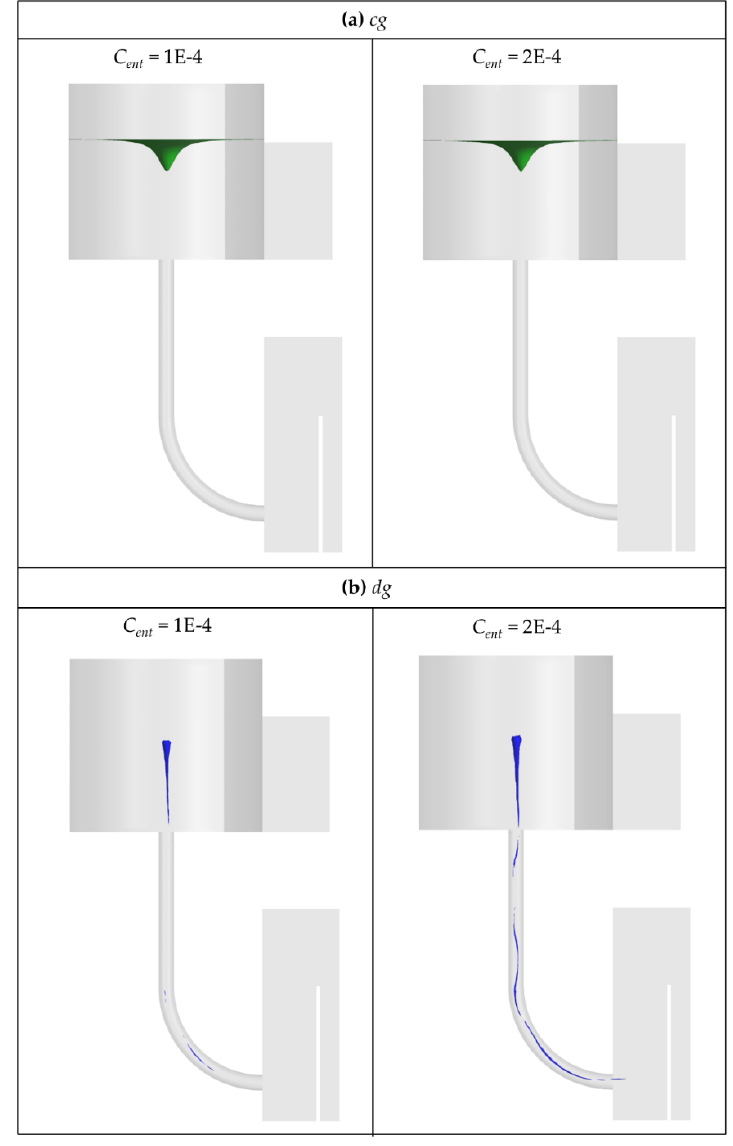
Figure 9. ( a ) Average interfacial deformation represented by isosurface of α cg = 0.5 and ( b ) average bubble entrainment represented by isosurface of α dg = 0.02. The results are obtained from the simulations using C scale = 1.